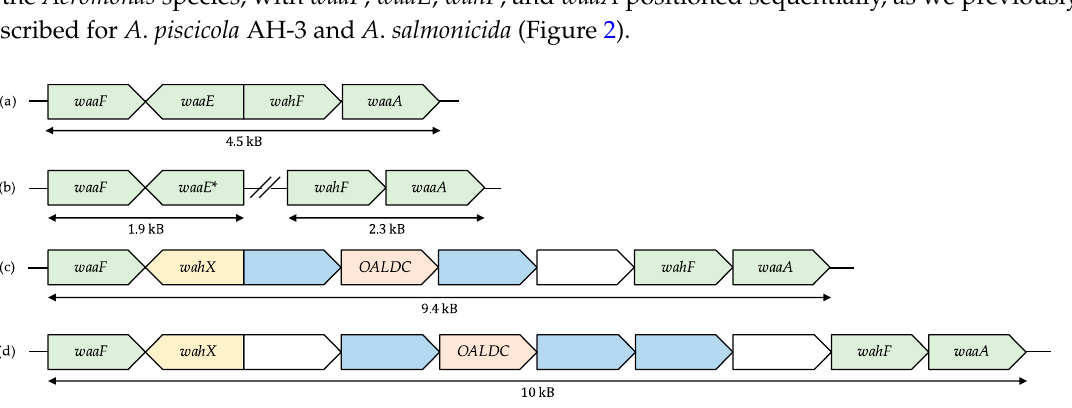
Figure 2. Comparison of the wa Region 2 in Aeromonas . ( a ) The most common genomic organization for this region found in the majority of Aeromonas species, with waaF , waaE , wahF , and waaA positioned sequentially in a gene cluster; ( b ) In the species A . diversa , A . schubertii , and A . simiae , this cluster is divided in two different genomic regions. Moreover, A . simiae presents wahX instead of waaE , marked with an asterisk; ( c ) A gene insertion of six genes containing wahX , a gene coding for an O-antigen ligase domain-containing protein (OALDC, in orange), and two glycosyltransferases (in blue) between waaF and wahF is found in the species A . bivalvium , A . molluscorum , and A . rivuli . Hypothetical proteins with unknown function are shown in white; and ( d ) Similarly, in the A . fluvialis genome, there is a gene insertion of seven genes containing wahX , a gene coding for an O-antigen ligase domain-containing protein, and three glycosyltransferases between waaF and wahF .